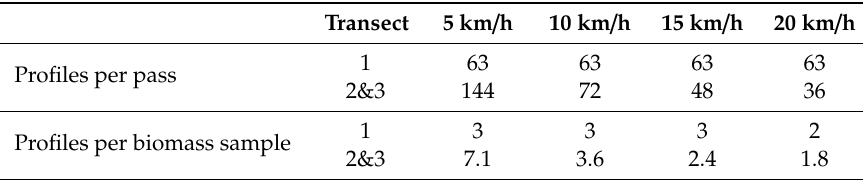
Table 3. Profiles per pass and per biomass